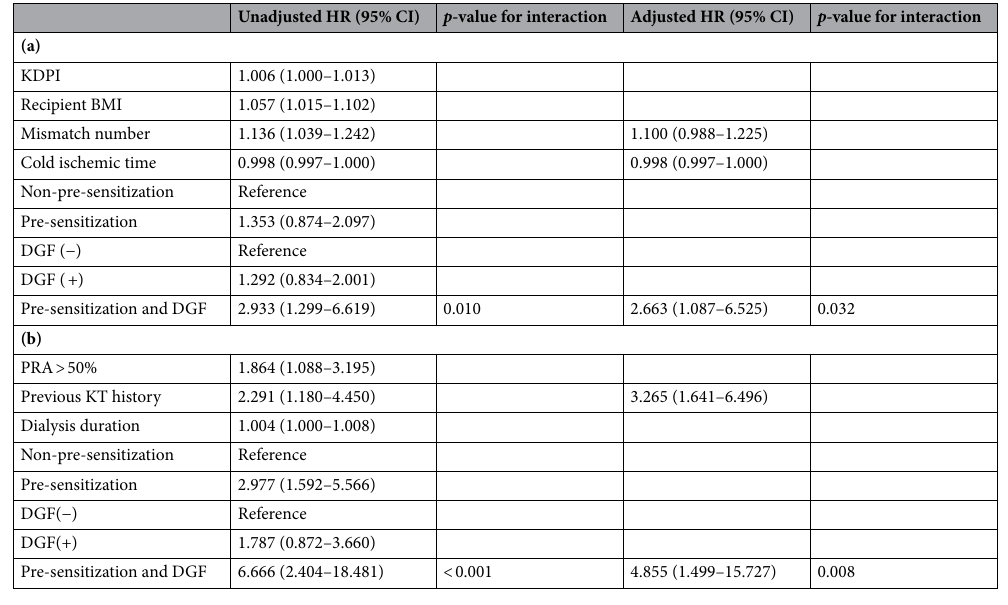
Table 3. Multivariable Cox regression for independent predictors of (a) overall BPAR and (b) acute ABMR. (a) Multivariable regression model was adjusted with parameters showing significant differences in univariable analysis or known to affect overall BPAR. Parameters were as follows: donor factors (cold ischemic time, KDPI), recipient factors (BMI, dialysis duration, previous KT history, mismatch number, PRA > 50%). 1021 (75.1%) recipients were included. (b) Multivariable regression model was adjusted with parameters showing significant differences in univariable analysis or known to affect acute ABMR. Parameters were as follows: donor factors (cold ischemic time, KDPI), recipient factors (dialysis duration, previous KT history, mismatch number, PRA > 50%). 1,023 (75.3%) recipients were included. BPAR biopsy-proven allograft rejection, ABMR antibody-mediated rejection, HR hazard ratio, CI confidence interval, KDPI kidney donor profile index, BMI body mass index, DGF delayed graft function, PRA panel reactive antibody, KT kidney